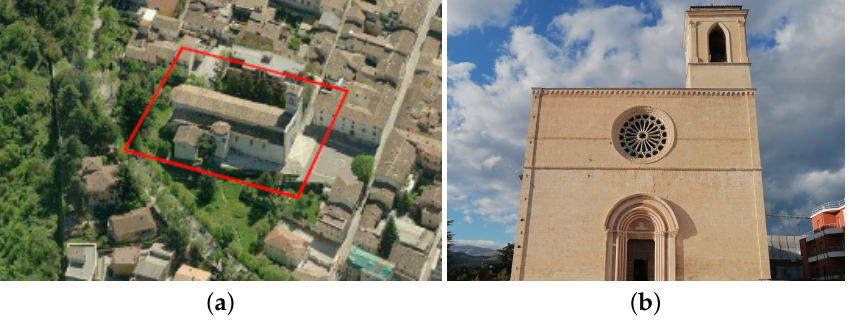
Figure 2. ( a ) Top view of the St.Silvestro Church (from https://earth.google.com, accessed on 15 March 2021); ( b ) View of the facade of the Church.